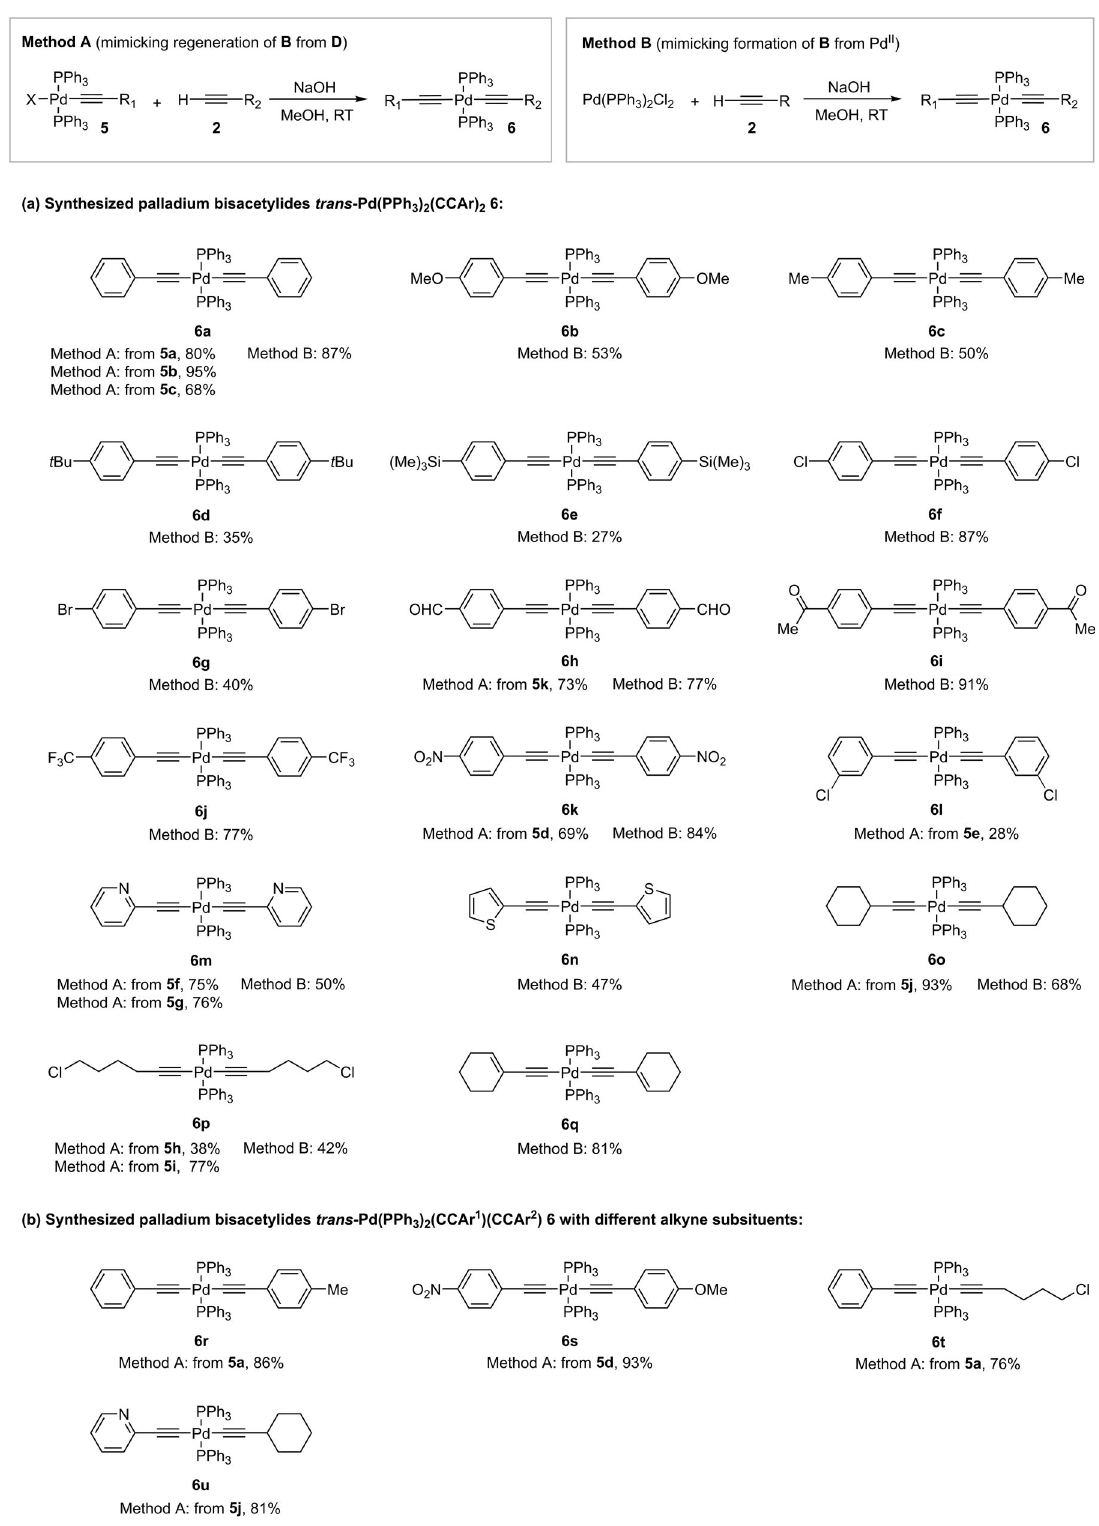
Fig. 4 Independently prepared palladium bisacetylides 6 that mimic intermediate C. a Synthesized symmetrical palladium bisacetylides 6 by Methods A and B. b Synthesized unsymmetrical palladium bisacetylides 6 by Method A. Method A mimics the regeneration of palladium bisacetylides C from monoacetylides D , and Method B the initial formation of palladium bisacetylides C from Pd II X 2 source. Synthetic details are described in Supplementary